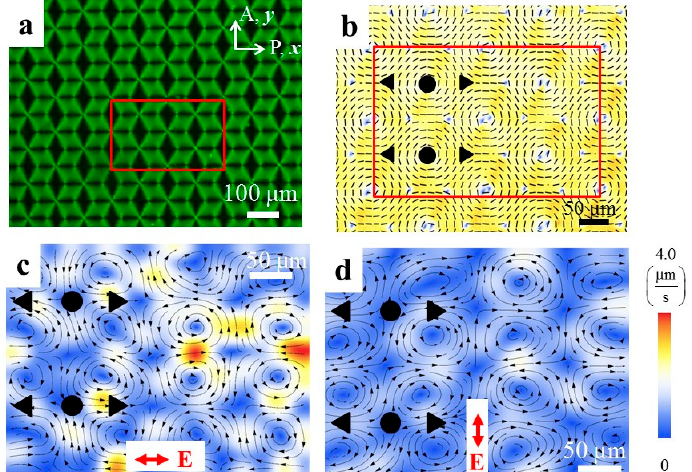
Figure 11. LCEO with surface patterned two-dimensional lattice of topological defects [26] . ( a ) Polarizing microscopy texture of a periodic array of disclinations; ( b ) PolScope texture of the area indicated in part ( a ); ( c ) Corresponding velocity field of LCEO flows in the region marked as red rectangle in ( b ) caused by the AC electric field along the x -axis; ( d ) Corresponding velocity field of LCEO flows caused by the AC electric field acting along the y -axis in the same region . Adapted with permission from [26].